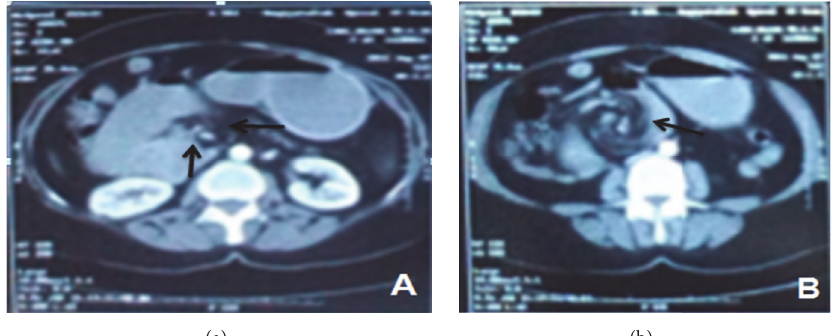
Figure 1: (a-b) CT scans obtained at the time of hospital admission. (a) shows collaterals of superior mesenteric veins surrounding the superior mesenteric artery. In (b) bowel is twisted around central superior mesenteric